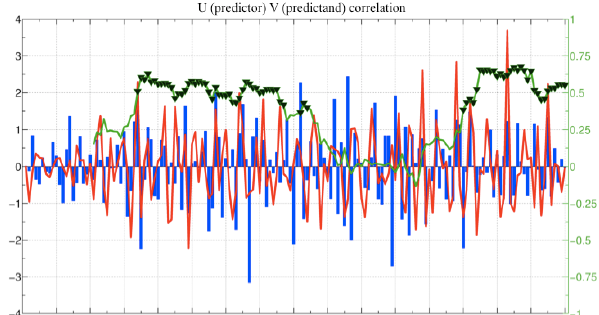
Figure 7. Shown are 21-year moving correlation windows (green line) between the expansion coefficients U corresponding to trop- ical Atlantic SSTA (predictor, blue bars) and V corresponding to tropical Pacific SSTA (predictand, red line) obtained for the leading mode of co-variability from MCA analysis between predictor and predictand fields. Shaded triangles indicate significant correlation under a Monte Carlo Test at